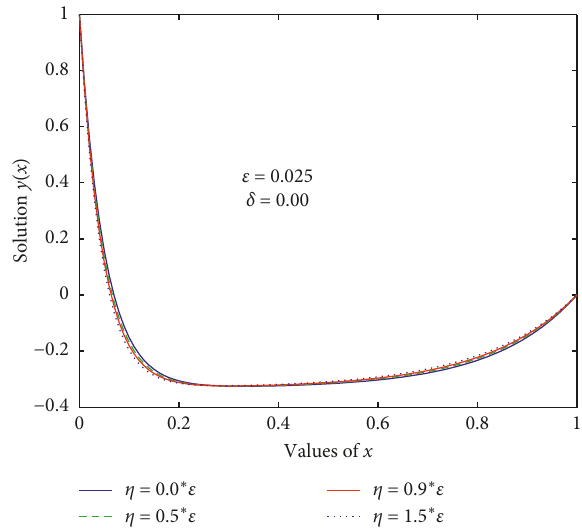
Figure 3: Approximate solution of Example 2 for different values of η